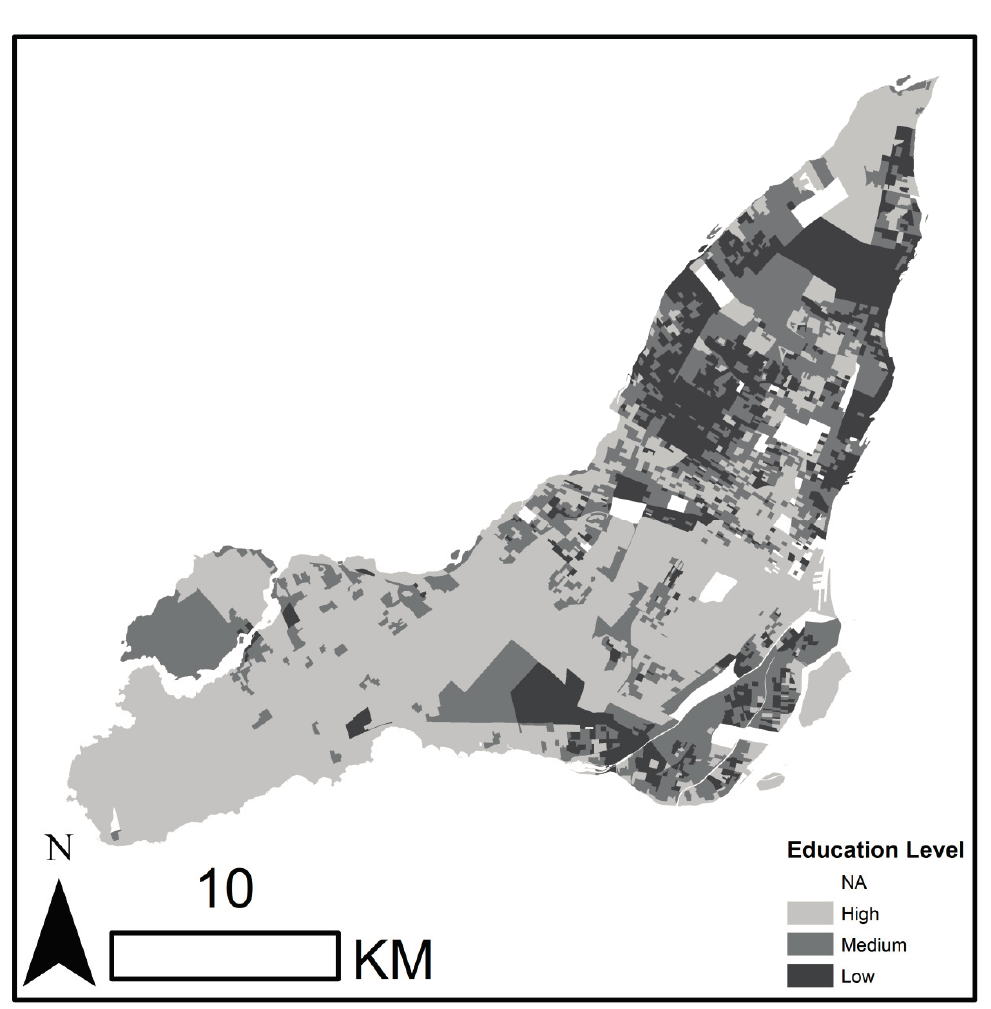
Figure 1. The spatial distribution of neighborhood social disparities in